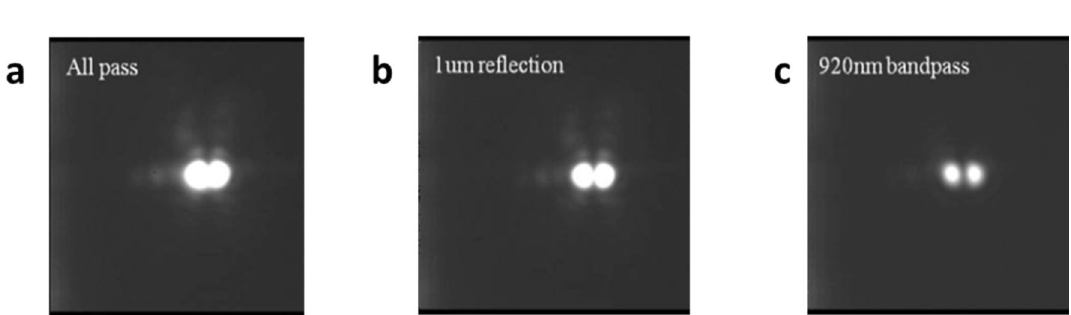
Figure 2. Experimental setup for Ta 2 O 5 waveguide SC generation. HWP: half-wave plate; PBS: polarizing beam splitter; AL: aspheric objective lens; LF: lensed fiber; OSA: optical spectrum analyzer; BPF: band pass filter; RF: reflector. Laser emits mode-locked pulse at a center wavelength of 1056 nm. The pulse duration is 111 fs and repetition frequency is 18 MHz.